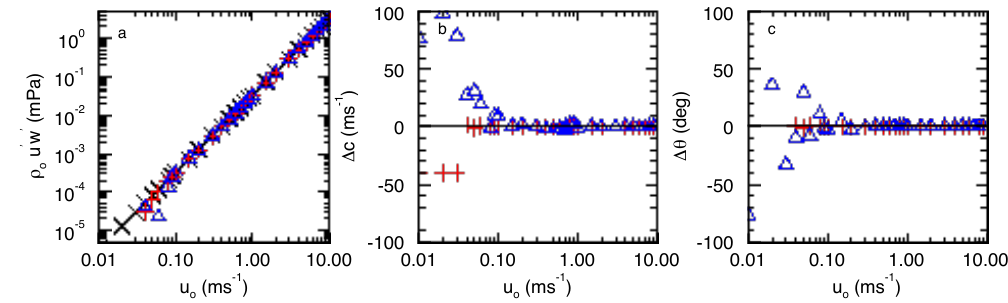
Fig. 5. (a) Values of momentum flux in mPa plotted as a function of wave packet amplitude, u o . The × symbols represent the input values, the red + indicate the retrieved values without instrumental noise and the blue triangles show the retrieved values with noise. (b) is similar to (a) , but where 1c = ˆ c sim − ˆ c in . (c) is similar to (a) , but where 1θ = θ sim − θ in